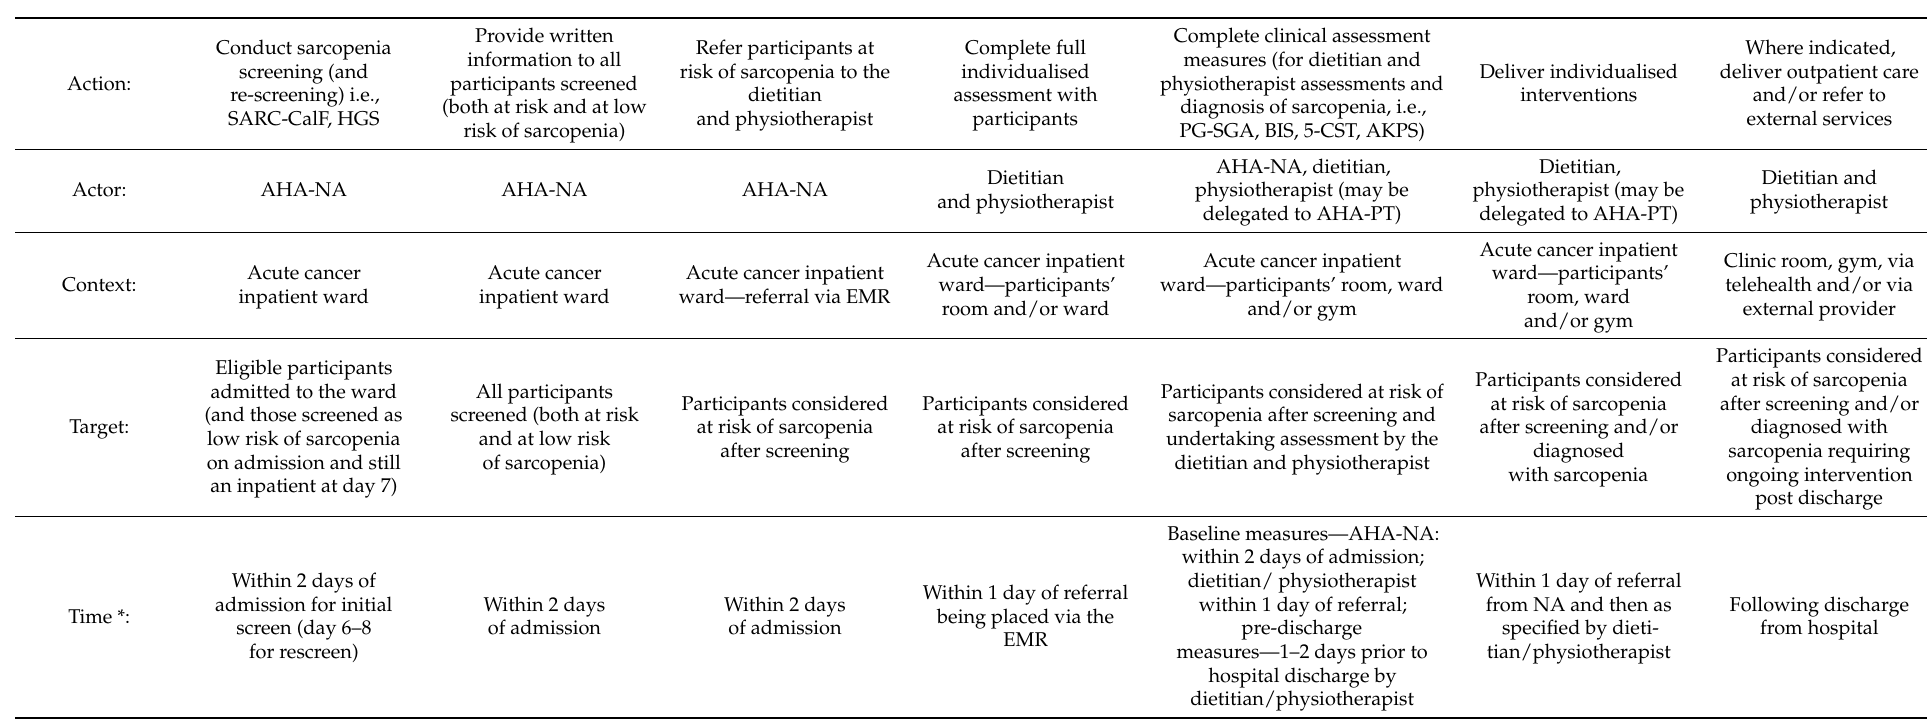
Table 1. Component behaviours of the sarcopenia pathway, described in accordance with the AACTT framework 1